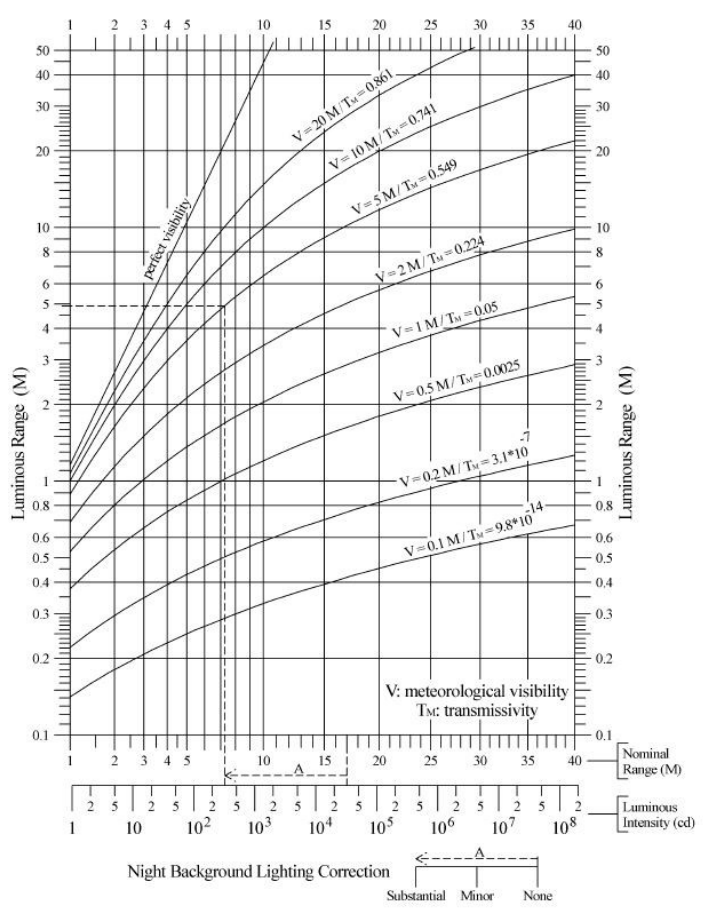
Figure 1. Luminous and nominal range at night.